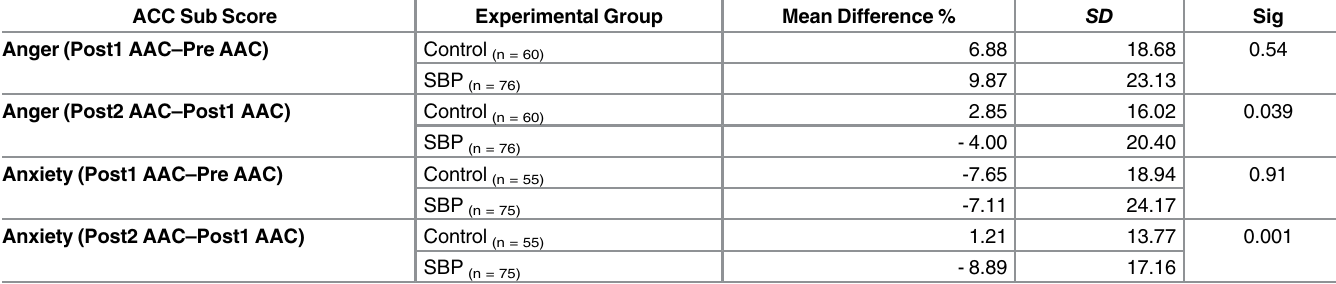
Table 2. Percentage differences between Post1-Pre and Post2-Post1 of the Anger and Anxiety AAC Composite Scores means for High Scorers (top 20% of the University Group). ACC Sub Score Experimental